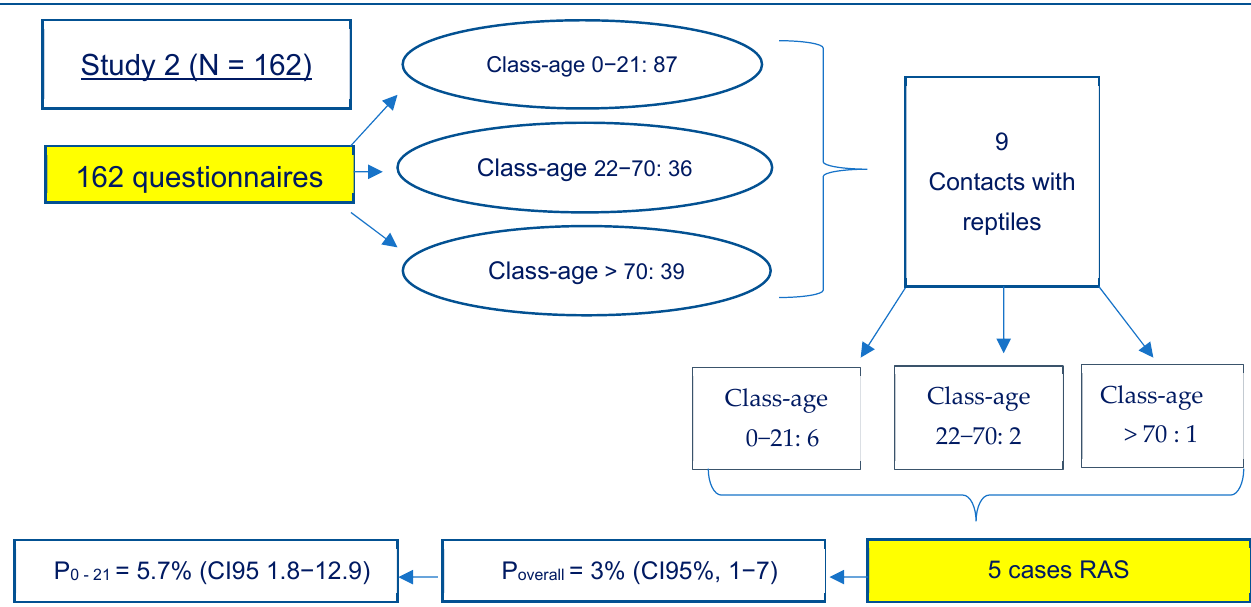
Figure 2. Results of the study carried out at the regional level.